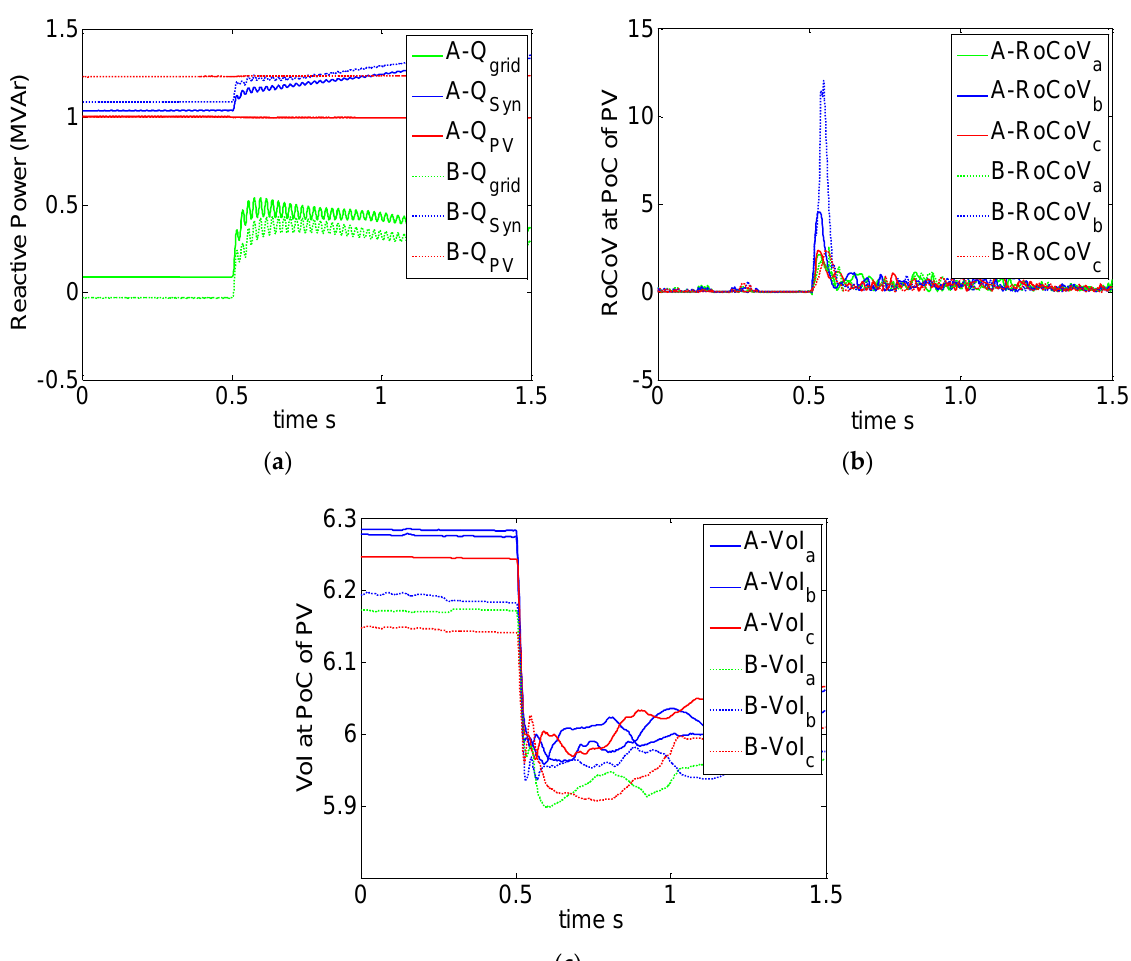
Energies 2021 , 14 , x FOR PEER REVIEW 16 of 18 Figure 14. Capacitor Switching in MG ( a ) Reactive power generation of DGs and grid, scenario A and B; ( b ) Rate of change of the voltages at the PoC of PV, scenario A and B; ( c ) The VoI index at the PoC of PV, scenario A and B for case 5.